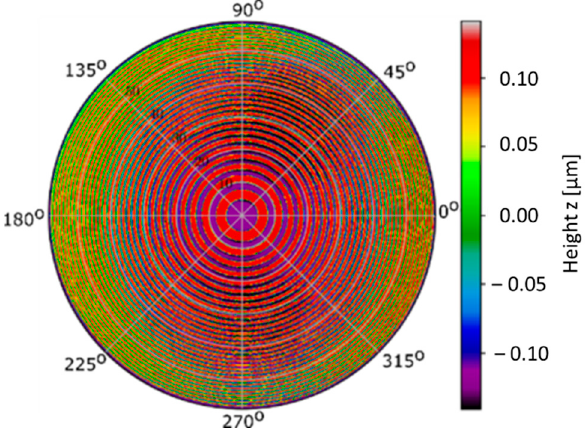
Figure 6. PTB chirp standard [27].